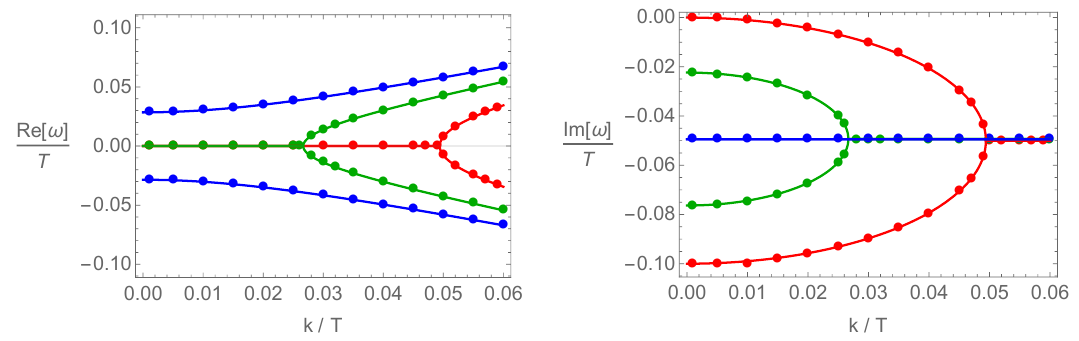
Figure 4 . The dispersion relation of the lowest collective modes in the transverse sector for different values of the reduced temperature T/T = (1 , 0 . 999 , 0 . 998) (red, green, blue). Symbols represent the c numerical values and solid lines are fits using eq.